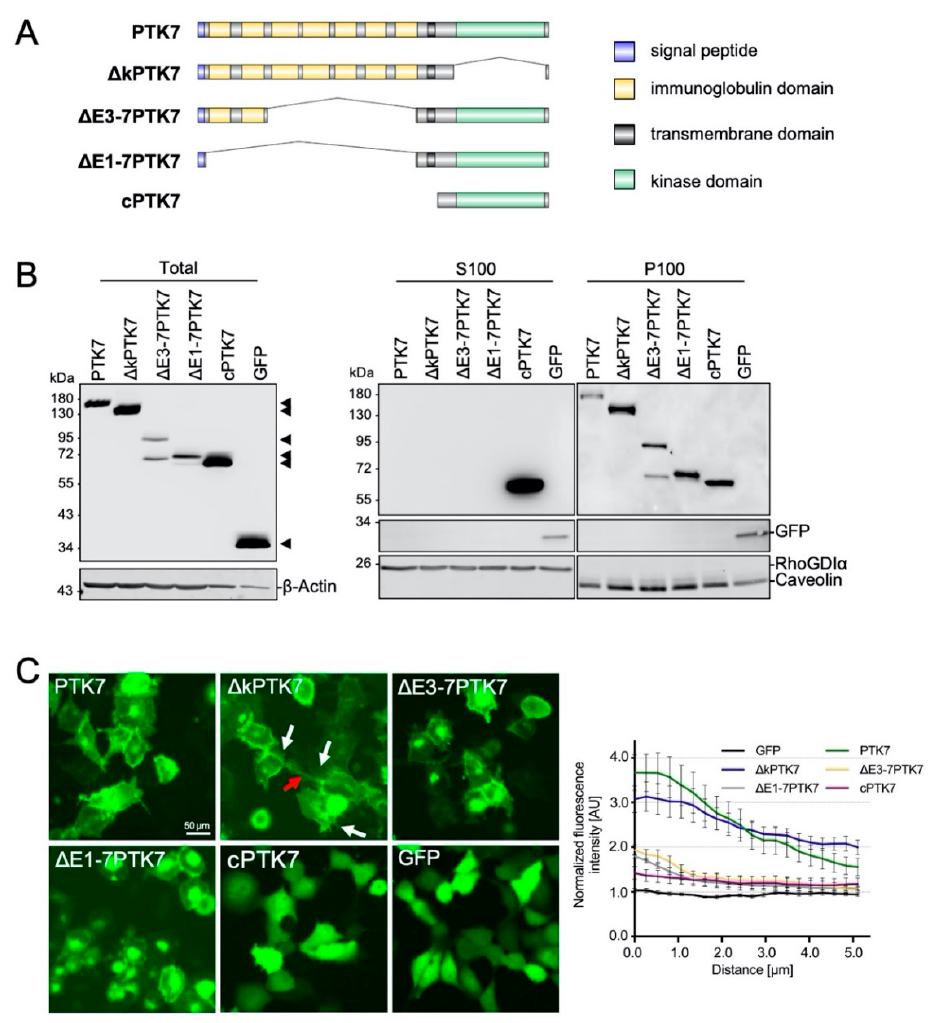
Figure 2. Localization of distinct Ptk7 deletion constructs in H1299 cells. ( A ) Schematic presentation of the Ptk7 domain structure and its different deletion mutants. ( B ) Transient expression of Ptk7-GFP variants in H1299 cells 24 h after transfection. Total cell lysates (left panel) were prepared by